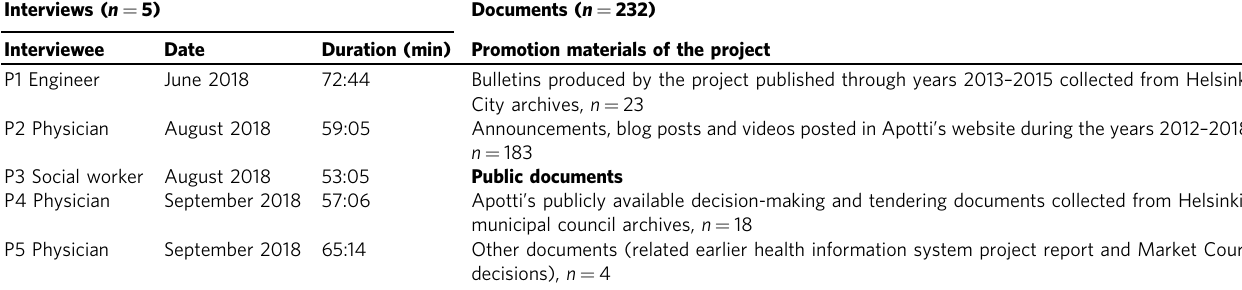
Table 1 Research